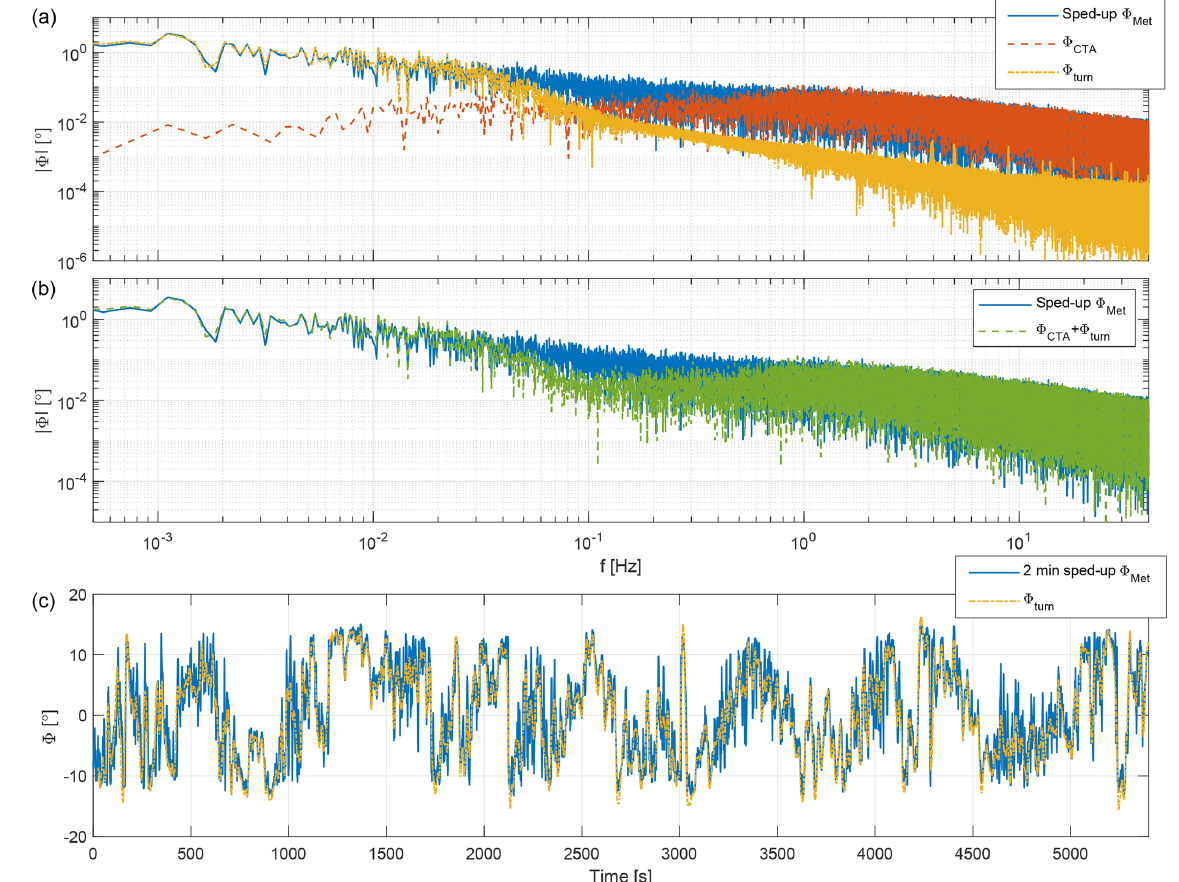
Figure 4. (a) Spectrum of the sped-up field-measured wind direction time series (cid:56) Met (solid blue), the turbulence-induced wind direction changes in the tunnel (cid:56) CTA (dashed red), and the turntable rotation (cid:56) turn (dashed–dotted orange). (b) Spectrum of the sped-up wind direction changes in the field (cid:56) Met (solid blue) and the combined wind direction changes in the wind tunnel (cid:56) CTA + (cid:56) turn (dashed green). (c) Time history of the 2min average of the sped-up field-measured wind direction (blue), compared to the time history used to drive the turntable rotation (dashed–dotted